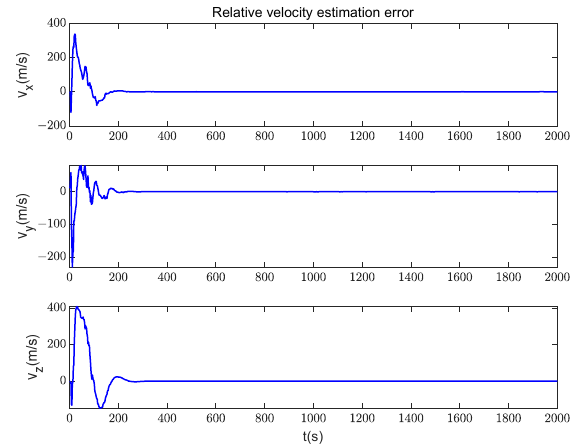
Figure 12. Relative position estimation errors.